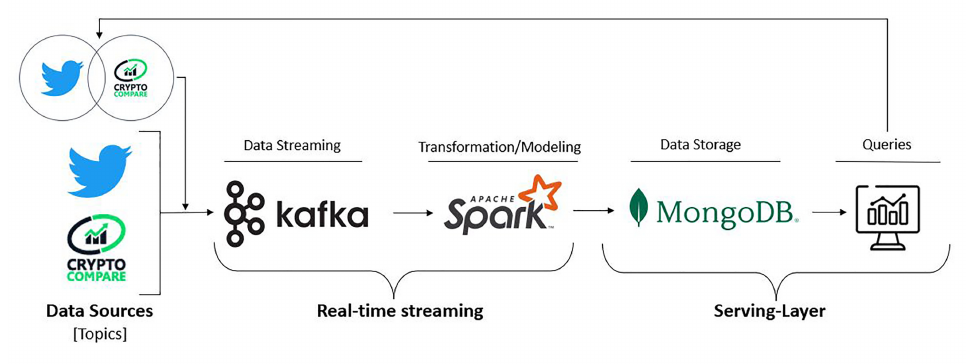
Figure 1. Proposed kappa architecture. Source: compiled by authors with data from [30]. “Apache Kafka”, and “Apache Spark” are trademarks of the Apache Software Foundation. “TWITTER, TWEET, RETWEET and the Twitter Bird logo are trademarks of Twitter Inc. or its